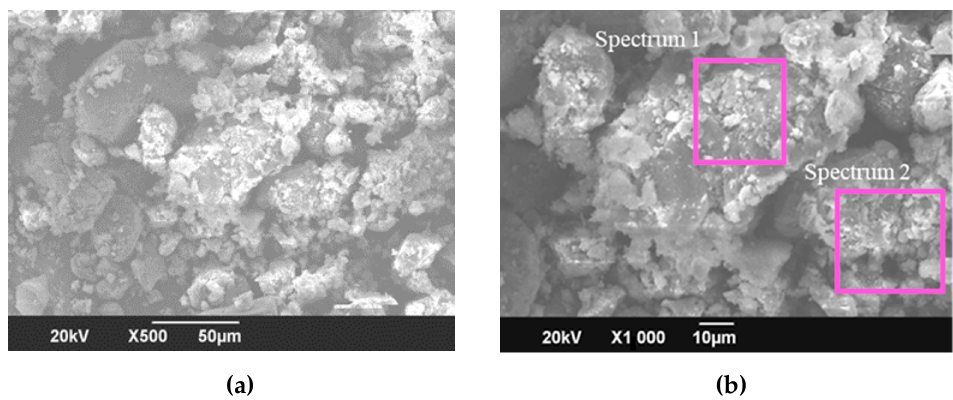
Figure 8. SEM Pictures of granitic soil at ( a ) 500× magnification and ( b ) 1000× magnification.